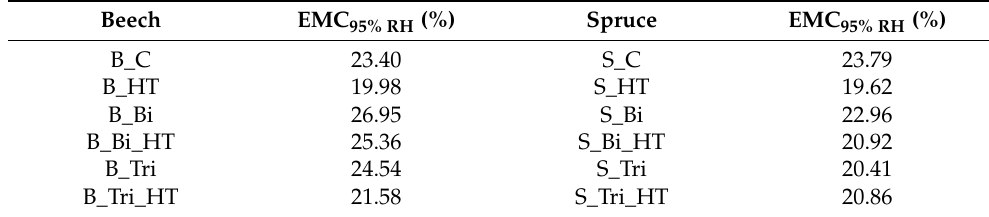
Table 5. Average equilibrium moisture content (EMC) values of combined milled samples at 95% relative humidity (RH). B = beech, S = spruce, Bi = bicine, Tri = tricine, HT = thermal modification, C =